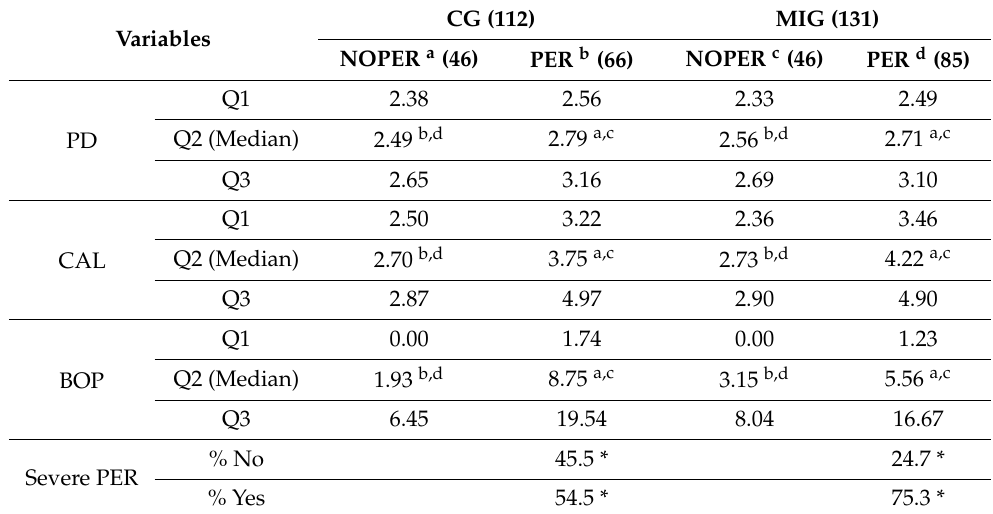
Table 2. Periodontal parameters of the four groups, Chi-square, Kruskal–Wallis and Mann–Whitney U test.